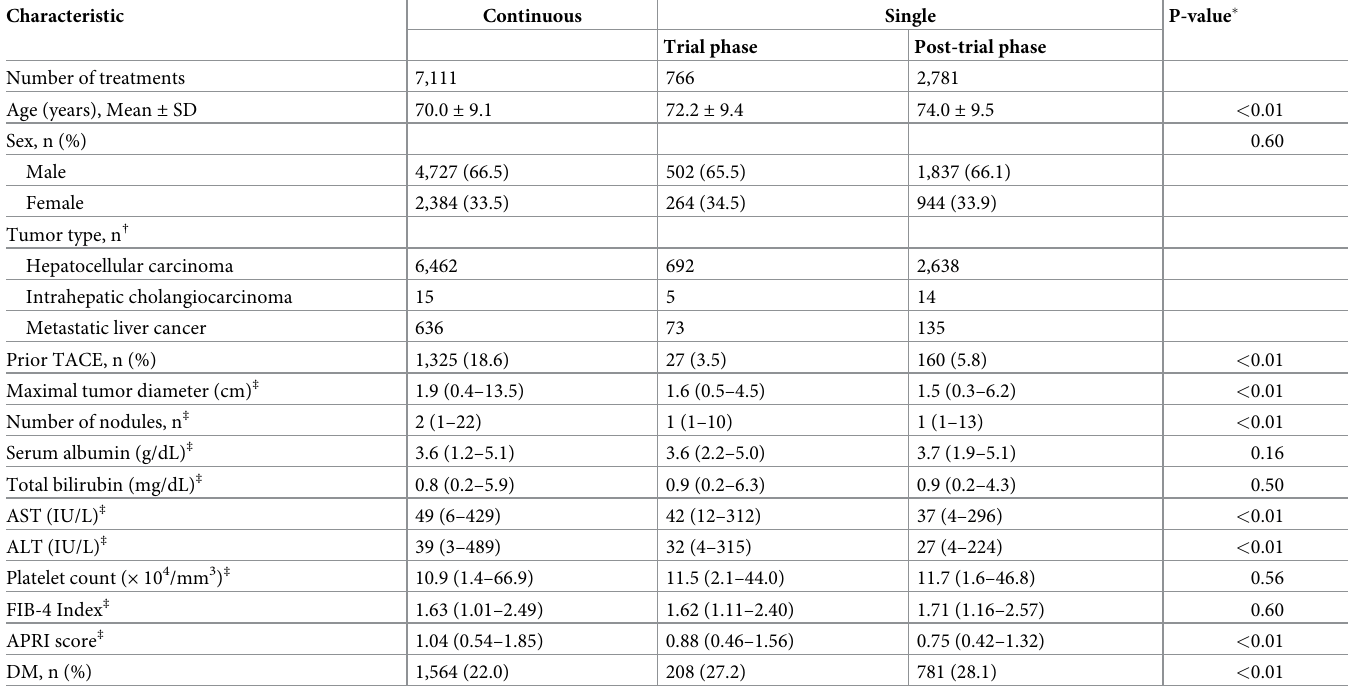
Table 1. Baseline